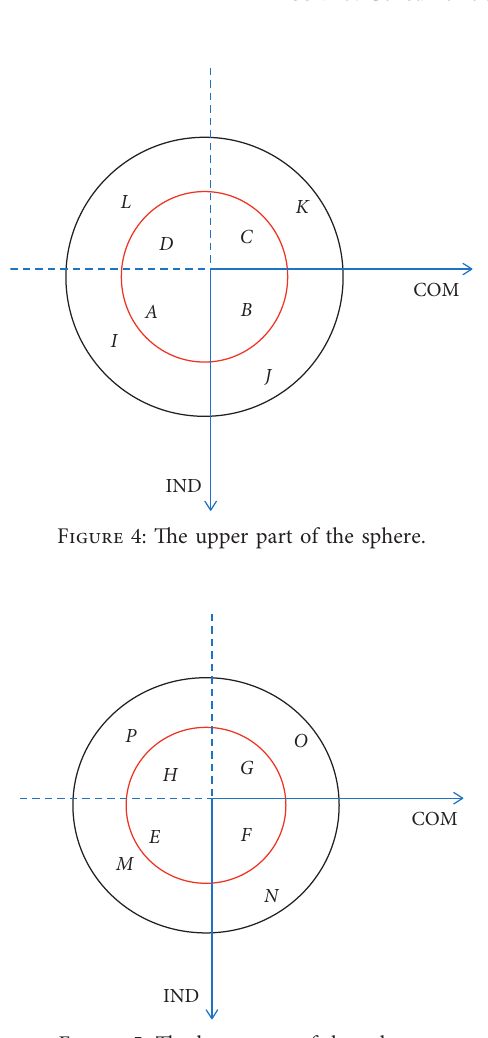
Figure 3: Consumer classifications based on purchase decision.